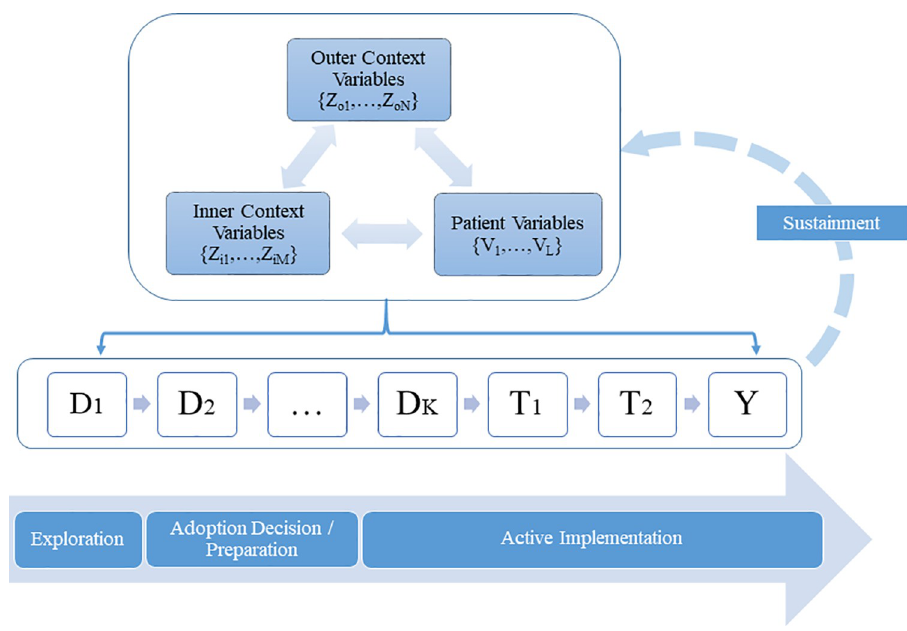
Fig 2. Multilevel decision juncture